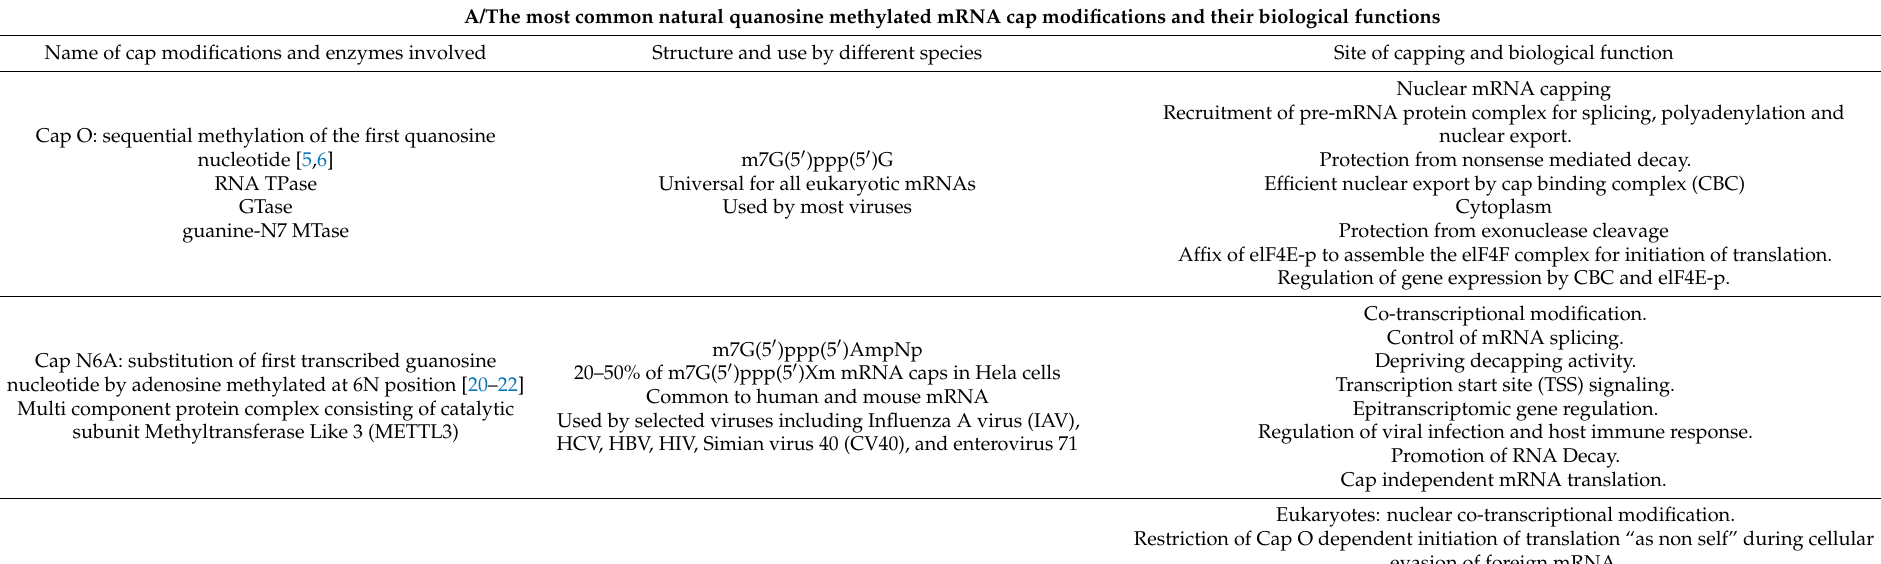
Table 1. The naturally existing caps of mRNAs and the synthesized caps used for mRNA vaccination. A/The most common natural quanosine methylated mRNA cap modifications and their biological